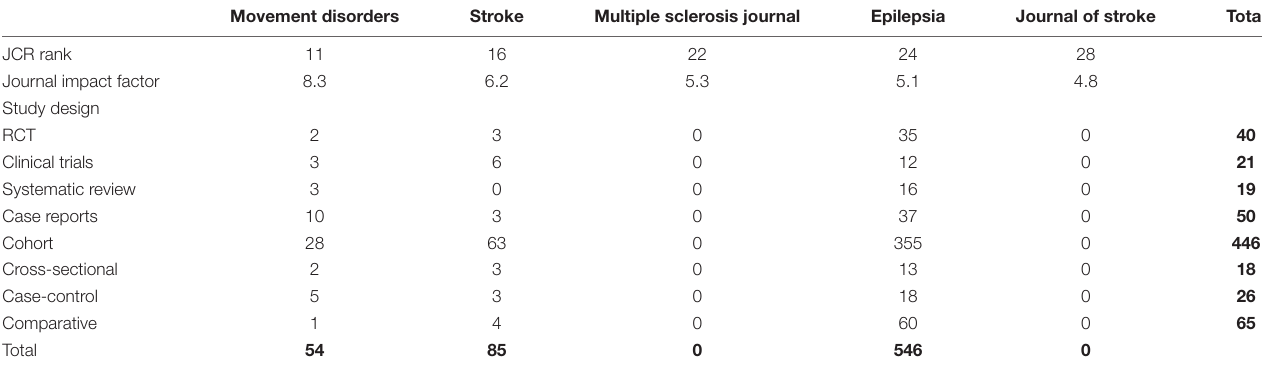
TABLE 4 | Productivity of the top 5 neurology subspecialty journals with distribution by journal and by study